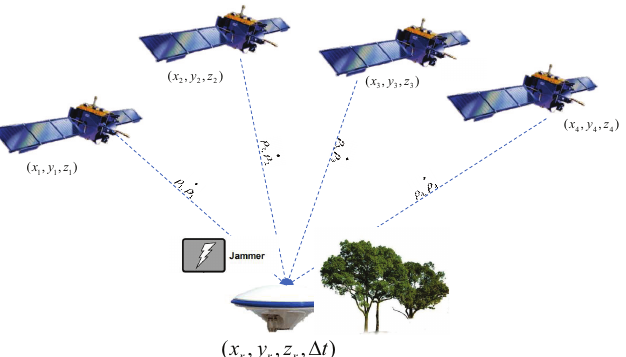
Figure 4. Diagram of GNSS positioning